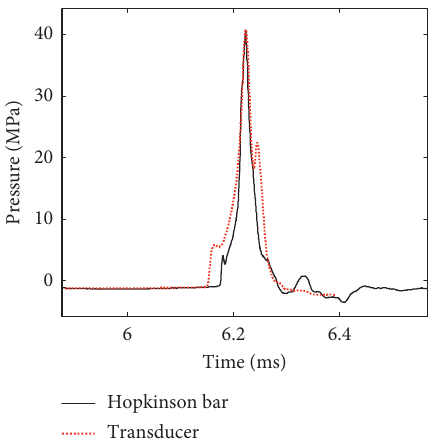
Figure 12: c � 0.67; Hopkinson bar measured data and transducer measured data comparison. Table 2: The relative errors of peak pressure between the Hop- kinson bar and pressure transducer.